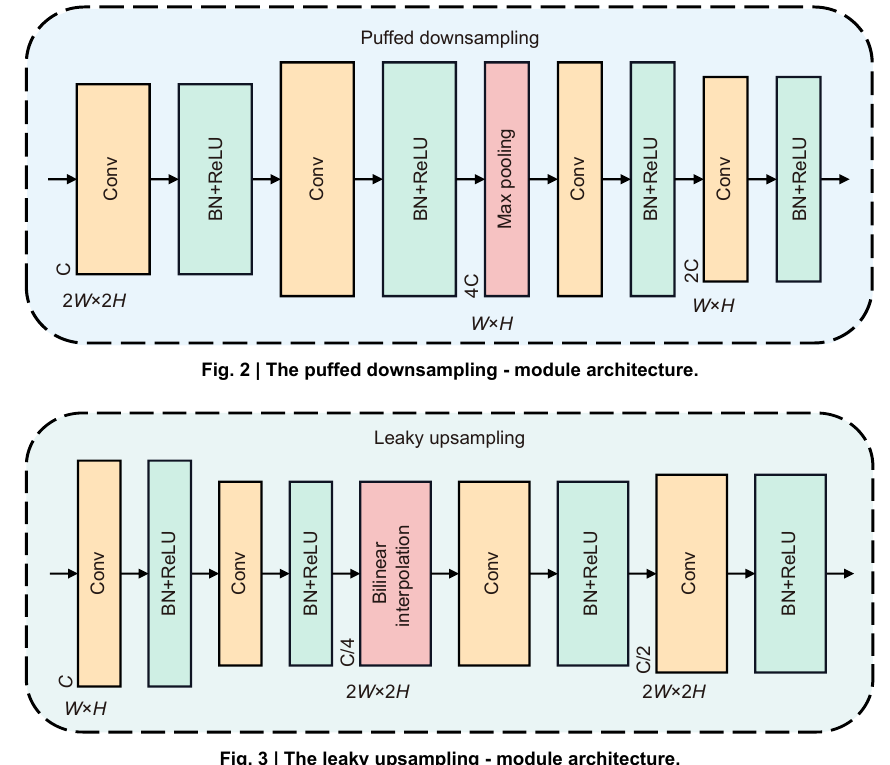
Fig. 3 | The leaky upsampling - module